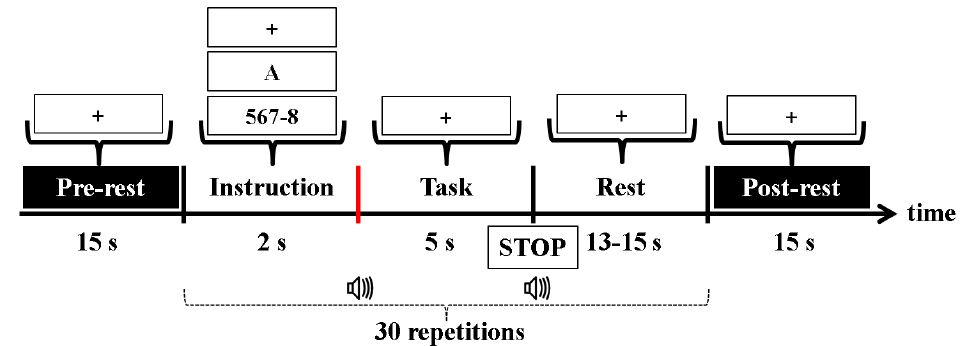
Figure 2. Schematic sequence diagram of the experimental paradigm for one session. Each session consists of a 15-s resting period, 30 repetitions of a given task, and a 15-s resting period. Each task starts with a 2-s visual introduction, followed by a 5-s task period and a 13–15-s rest period starting with a “STOP” sign on the screen for 2 s. At the beginning and end of the task period, a short beep was played for 250 ms. At the instruction, +, A, and 567-8 indicate the baseline (BL), word chain (WC), and mental arithmetic (MA) tasks, respectively. The red vertical line indicates the task onset. The task onset was the time when the participants started to perform the numerical calculation (MA), state words (WC), and be relaxed (BL).